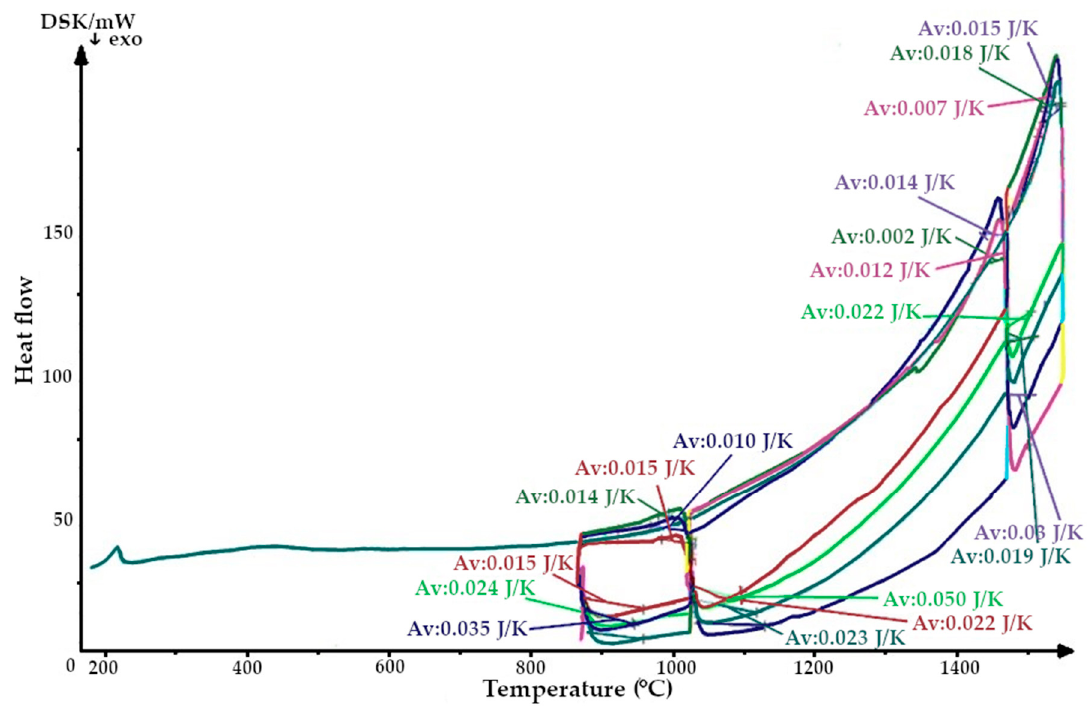
Figure 7. Thermogram of a quartzite, calcified at 200 ◦ C and sintered with an induction furnace’s lining.